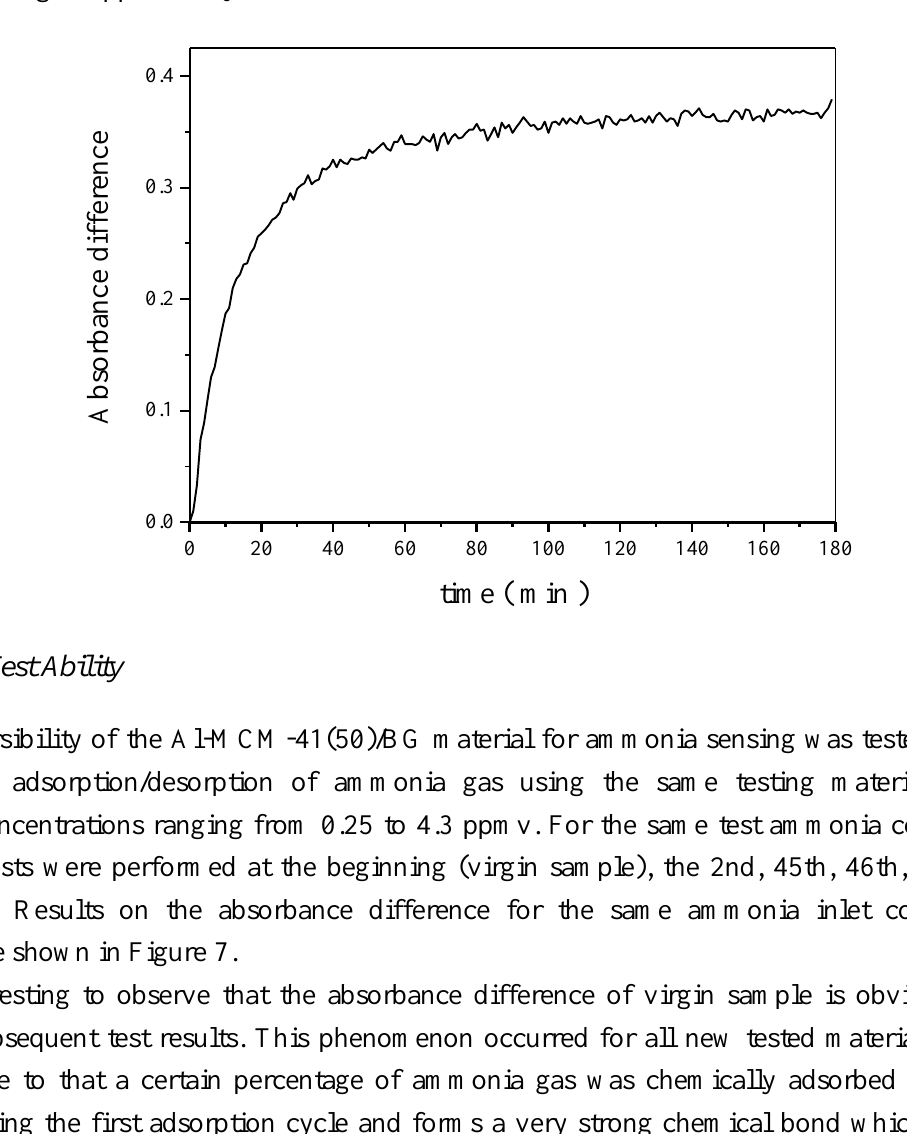
Figure 6. Time response on the absorbance difference of the Al-MCM-41(50)/BG for monitoring 4.3 ppmv NH 3